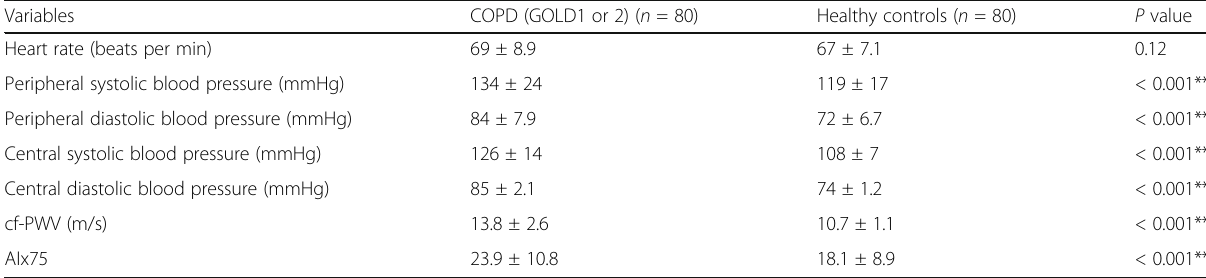
Table 2 Hemodynamic parameters of all studied participants Variables